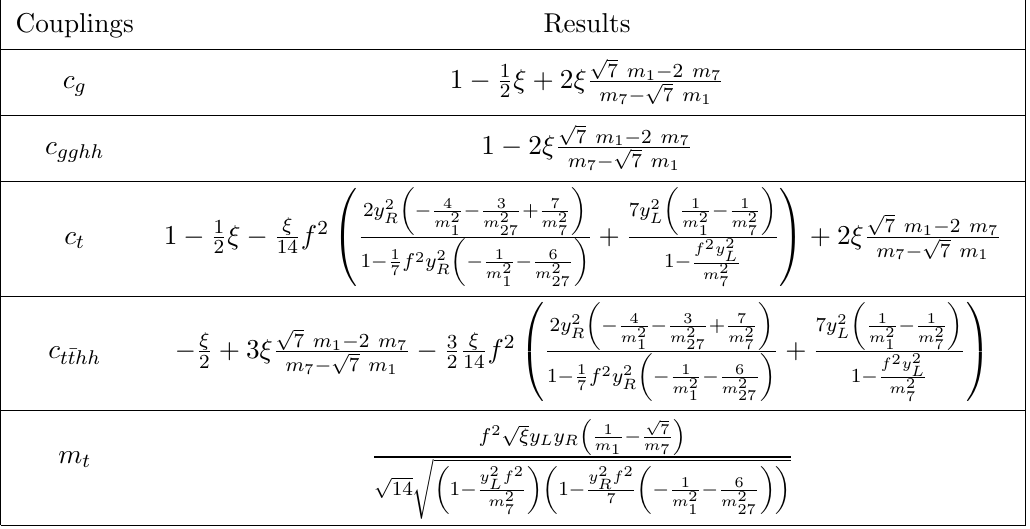
Table 9 . Higgs Couplings and top mass in CTHM of 8 + 35 Representation, which means t L is embedded in the 8 of SO(8) while t R is embedded in the 35 of SO(8).